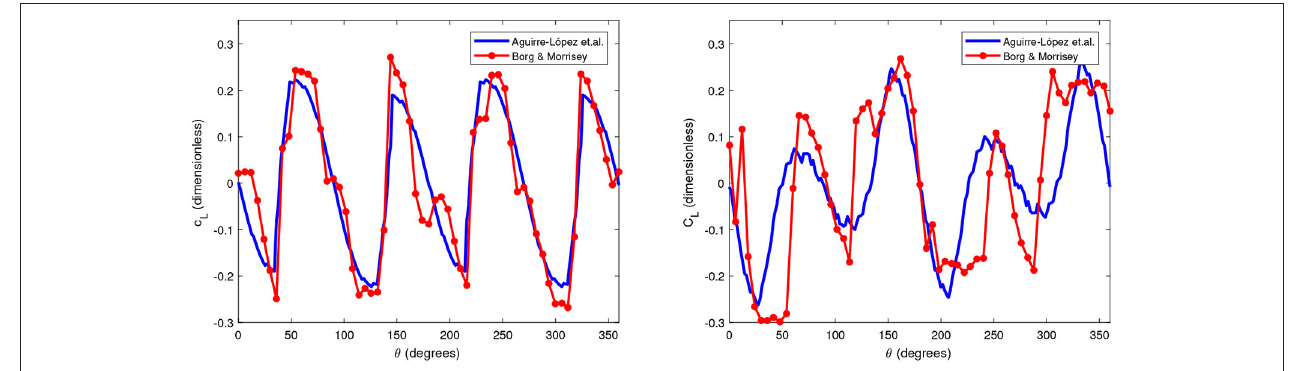
FIGURE 4 | Experimental data [36] and model [41] of C L as a function of the attack angle θ for 4S (A) 2S (B) balls. Modified from Aguirre-López et al.